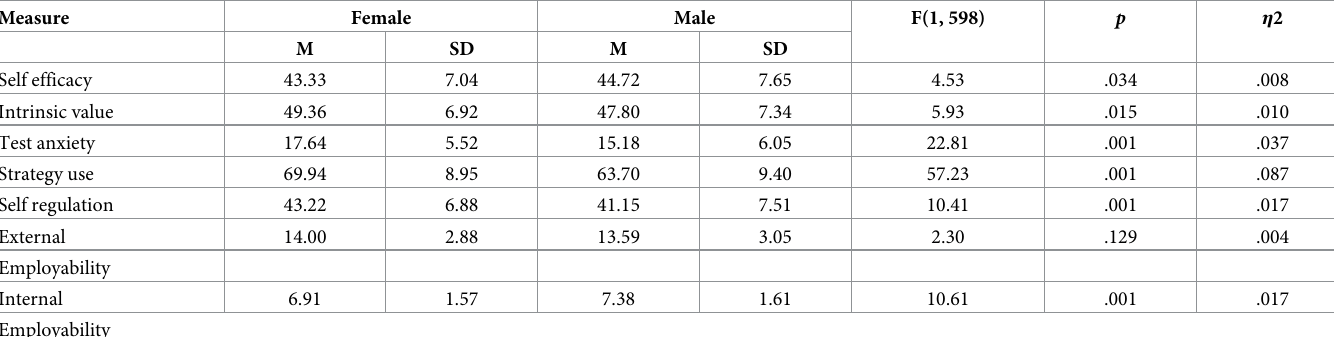
Table 2. Means, standard deviations, and one-way